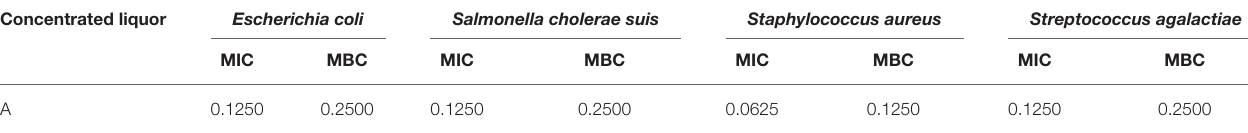
TABLE 2 | MIC and MBC of fermented compound Chinese medicine feed additive A, g/ml.